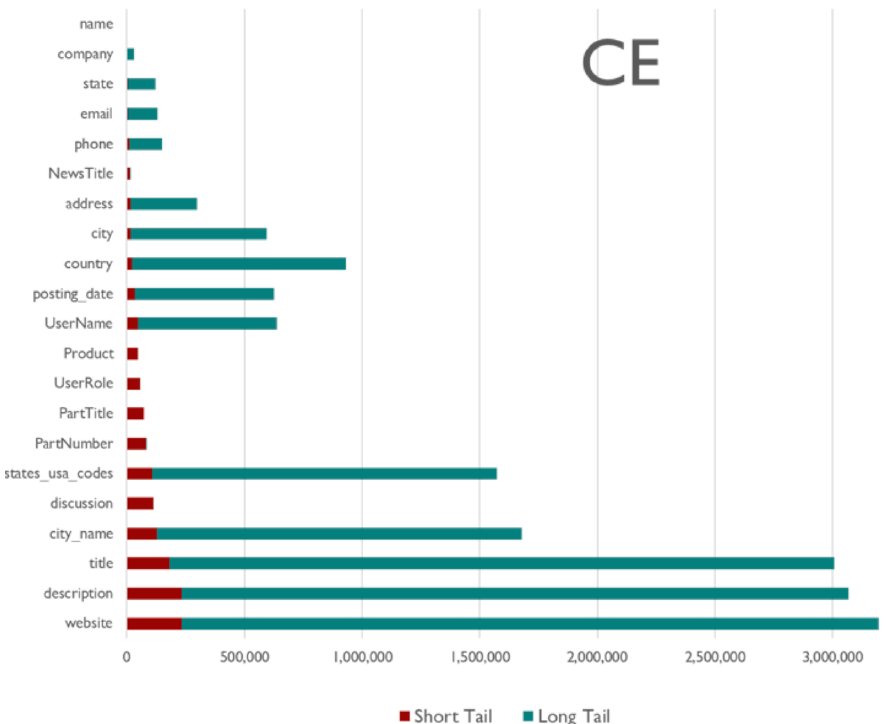
Figure 13. For the CE domain, a comparison of web page count (x-axis) such that at least one value per field (y-axis) was extracted from that website (green bar/long tail), against the short tail/red bar wherein only Inferlink extractions are considered.